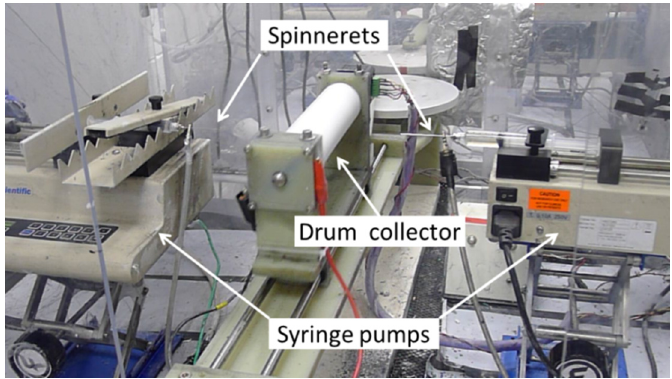
Figure 1. Schematic of the dual fiber electrospinning setup used in the present study.